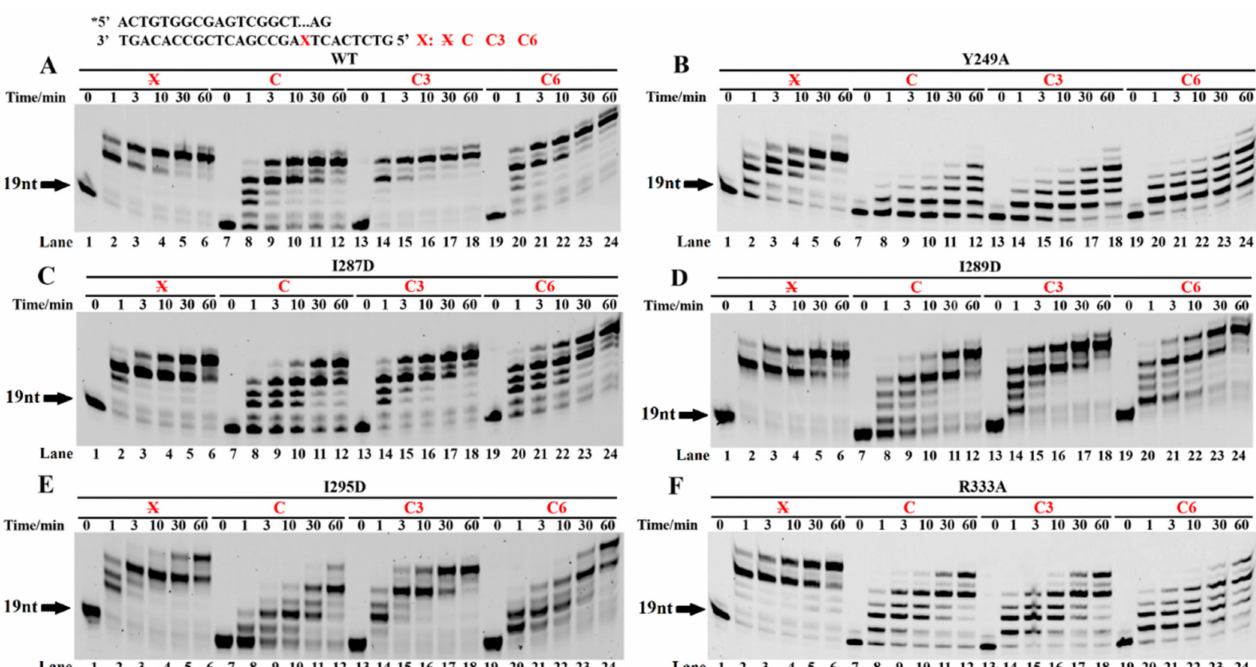
Figure 6. TLS by LF domain mutants of Dbh. The PT DNA substrates are shown at the top of the figure, where the letter X denotes base C and spacers C3 and C6. The symbol X denotes the normal DNA template. The PT DNA substrates, with 3 (cid:48) -pairing two normally paired base pairs downstream of the AP site in the template strand, were incubated with dNTPs and 0.2 µ M wt Dbh ( A ), or the mutant Y249A ( B ), I287D ( C ), I289D ( D ), I295D ( E ), or R333A ( F ) at 45 ◦ C for 0, 10, 20, and 60 min.